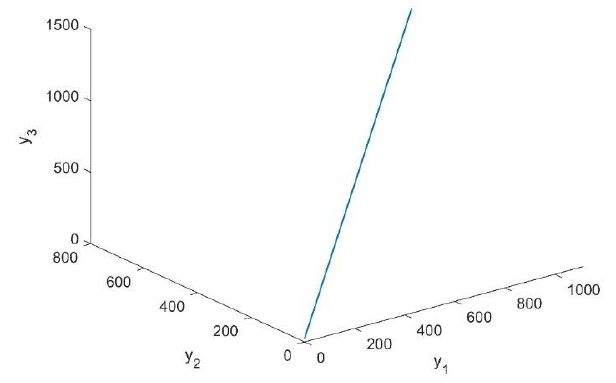
Figure 5. ( y 1 , y 2 , y 3 )-phase Figure 5. (y 1 , y 2 , y 3 )-phase diagram.